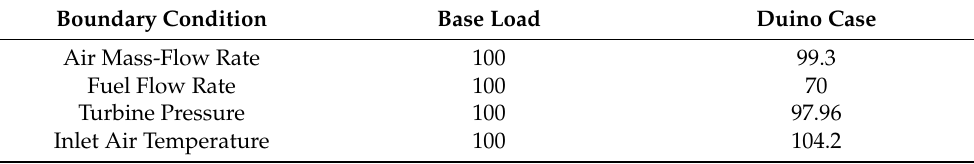
Table 6. Base load vs. Duino case boundary conditions.